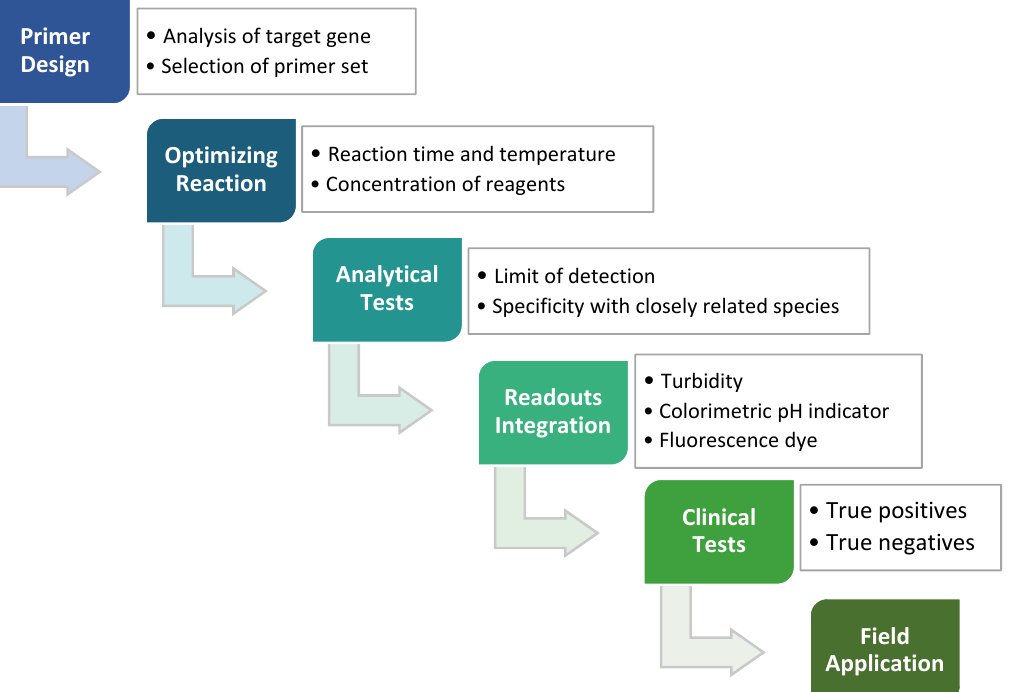
Figure 2. The process of developing the LAMP method, which starts from the designing of LAMP primers against target genes, followed by the reaction optimizations, analytical tests, readouts integration and lastly clinical tests. An applicable LAMP method can eventually be applied to field diagnostics such as screening routines or the production of LAMP kits.